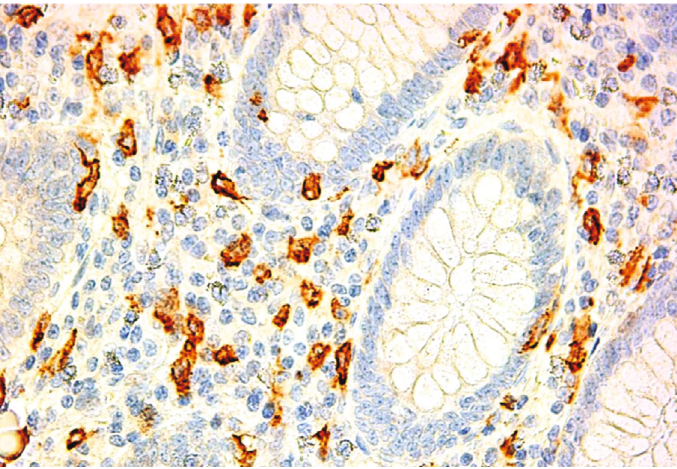
Figure 2: IgE immunostaining, acute appendicitis.